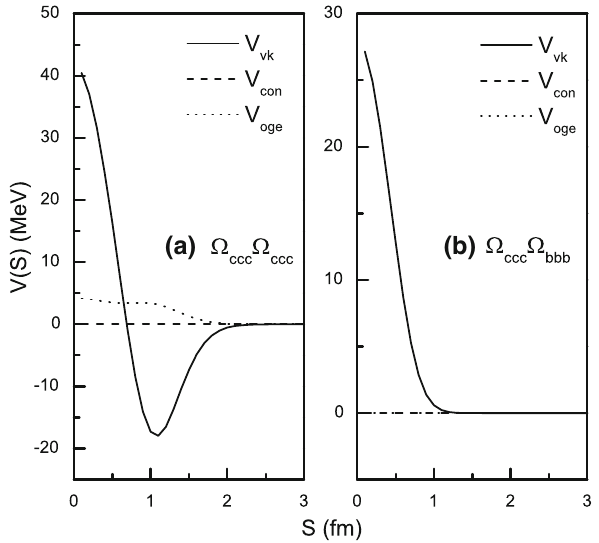
Fig. 3 The contributions to the effective potential from the kinetic energy ( V v k ), the confinement ( V con ), and the one-gluon exchange ( V oge ) of the Ω ccc Ω ccc and Ω ccc Ω bbb systems with J P = 0 +